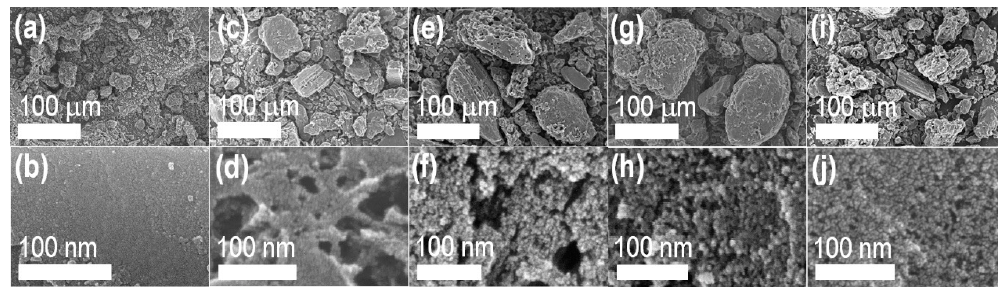
Figure 1. SEM images of Washnut seed-derived nanoporous activated carbons: ( a , b ) WNP_800; ( c, d